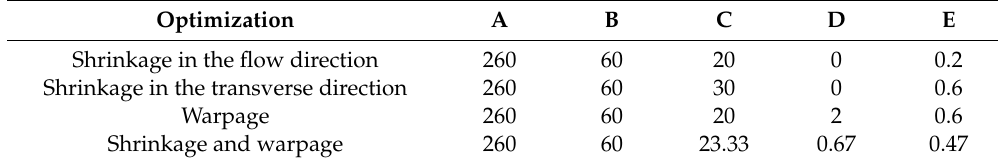
Table 5. Optimum condition defined by the Taguchi method.